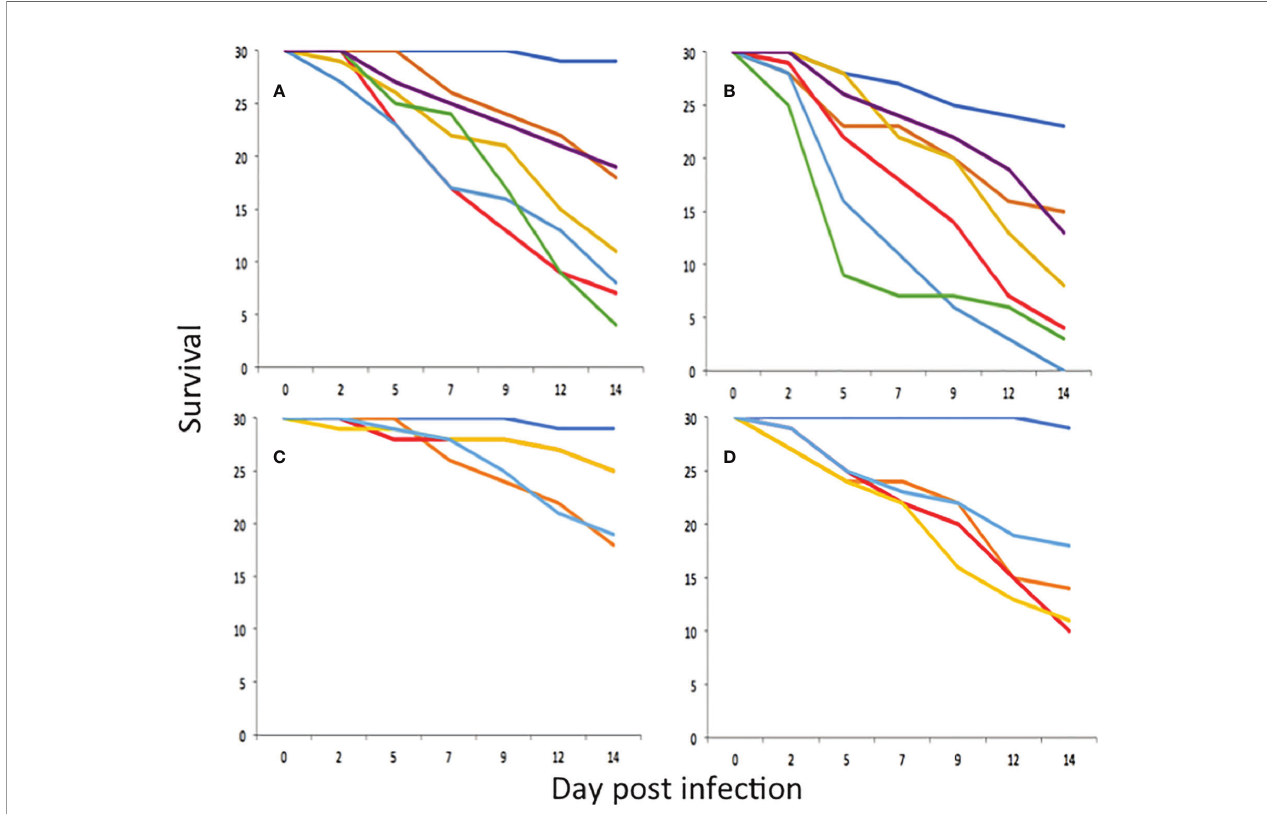
FIGURE 2 | Survival of D. invadens (n = 30) exposed to no nematodes (dark blue), P. hermaphrodita DMG0001 (orange), P. neopapillosa DMG0012 (red), P. neopapillosa DMG0013 (yellow), P. neopapillosa DMG0014 (light blue), P. neopapillosa DMG0015 (green) and P. neopapillosa DMG0016 (purple) at dose rates of 500 (A) and 1000 (B) nematodes per ml. Survival of D. invadens (n = 30) exposed to no nematodes (dark blue), P. hermaphrodita DMG0001 (orange), P. californica DMG0017 (red), P. californica DMG0018 (yellow) and P. californica DMG0019 (light blue) at dose rates of 500 (C) and 1000 (D) nematodes per